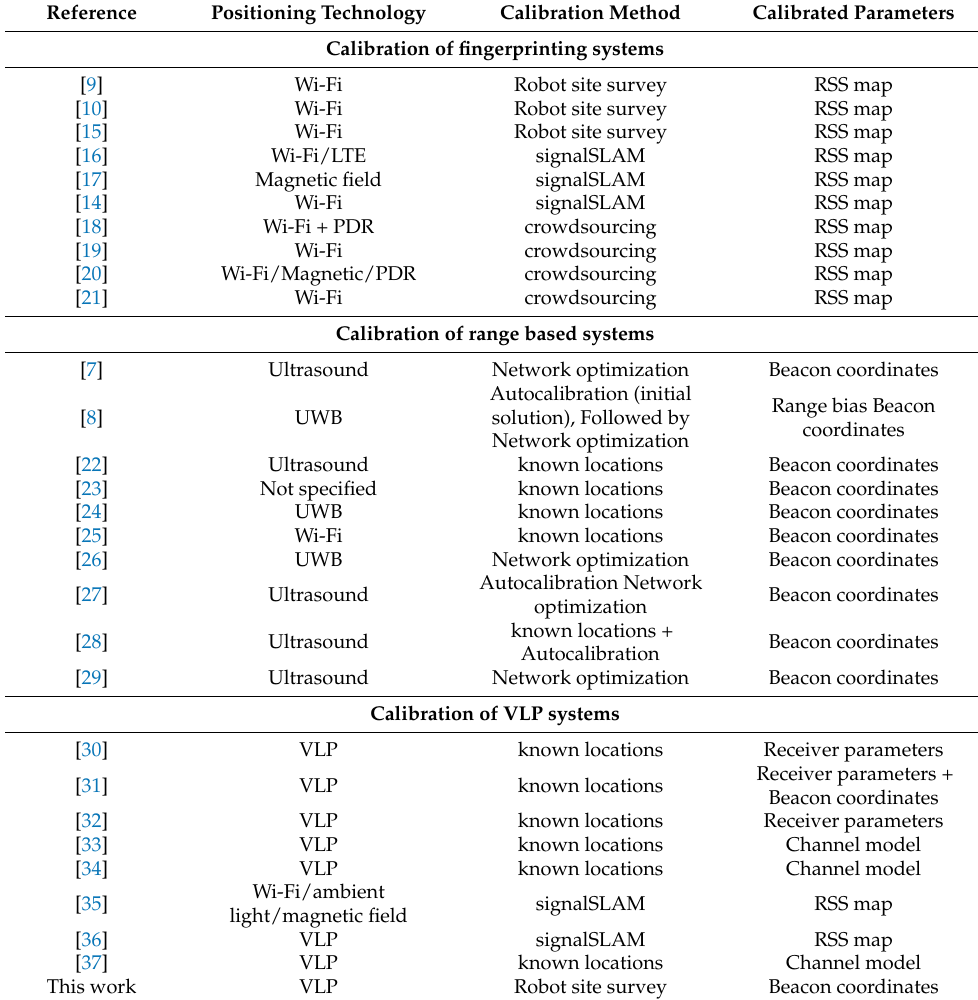
Table 1. Calibration approaches for indoor positioning